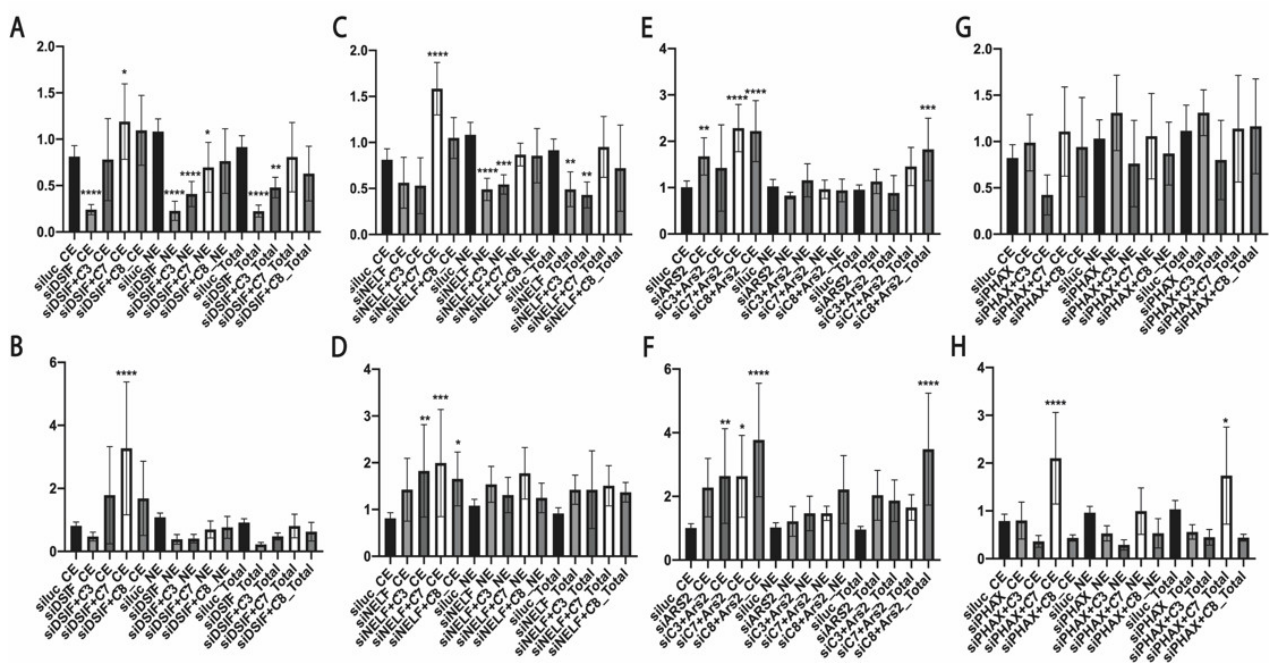
Figure 2. The role of RNA biogenesis factors in hTR processing and transport. ( A , C , E , G ) Histograms demonstrated the relative amount of total (M+3′) hTR transcripts in the cytoplasmic (CE) and nuclear (NE) fractions and in the whole cell extract (Total) after the knockdown of the specified RNA biogenesis factor. ( B , D , F , H ) Histograms demonstrating the relative amount of prematured (3′) hTR transcripts in the cytoplasmic (CE) and nuclear (NE) fractions and in the whole cell extract (Total) after the knockdown of the specified RNA biogenesis factor. siluc — control knockdown performed with siRNA specific to Firefly luciferase mRNA; siC3 — knockdown performed with siRNA specific to ZFC3H1; siC7 — knockdown performed with siRNA specific to ZCCHC7; siC8 — knockdown performed with siRNA specific to ZCCHC8. * p < 0.1,** p < 0.01, *** p < 0.001, and **** p < 0.0001 by Dunett’s multiple comparison test.